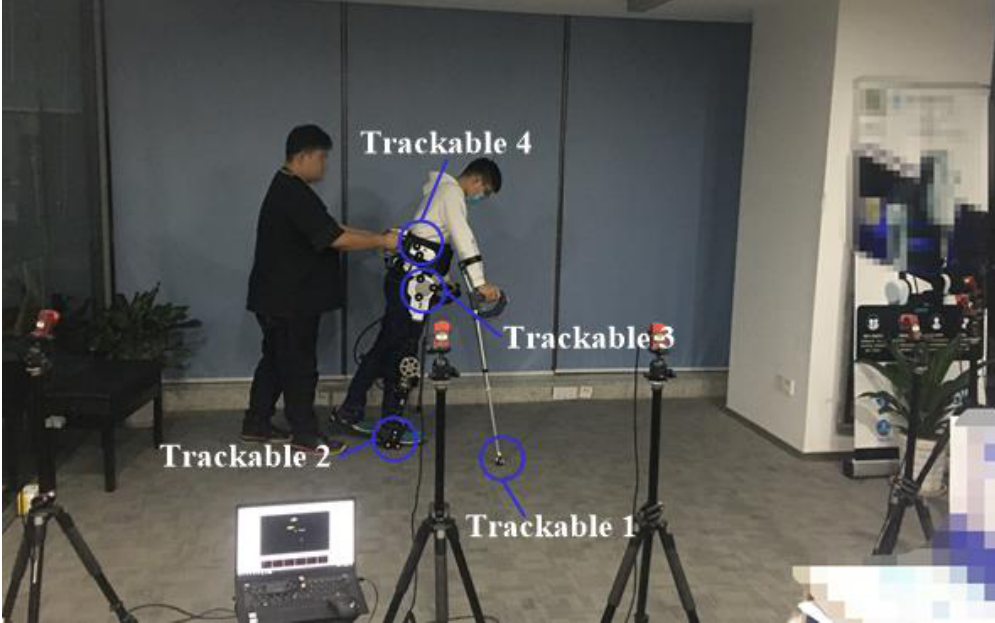
Figure 10. Exoskeleton-assisted walking test. Six cameras were grouped for motion capture of four trackable points. The exoskeleton was programmed to perform seven steps, including the first and last predefined transfer steps. The gaits of the other five steps were planned online based on CoP results.